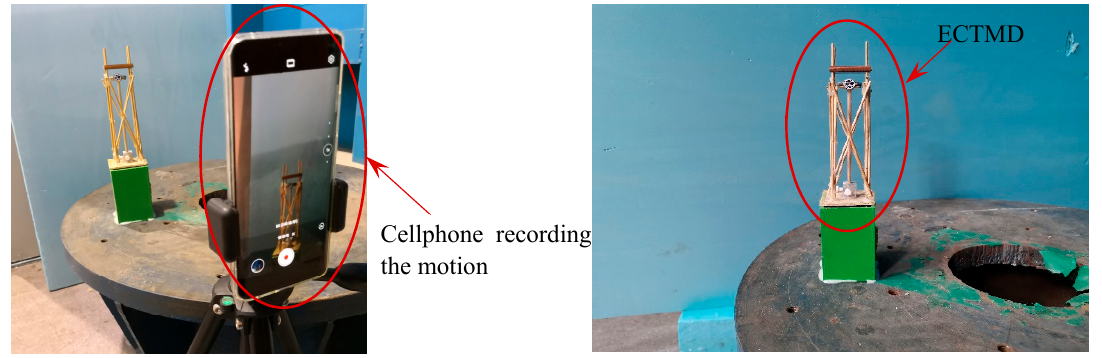
Figure 4. Experimental setup of free vibration test of ground-mounted ECTMD.